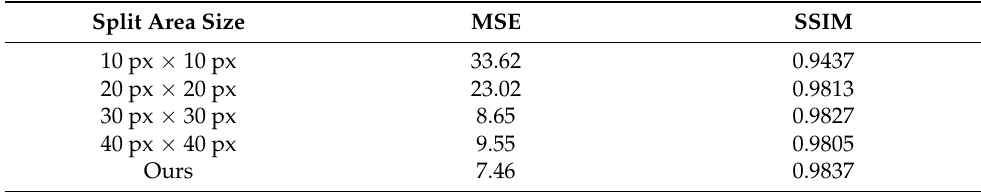
Table 1. Performance of di ff erent partition areas in the test set.